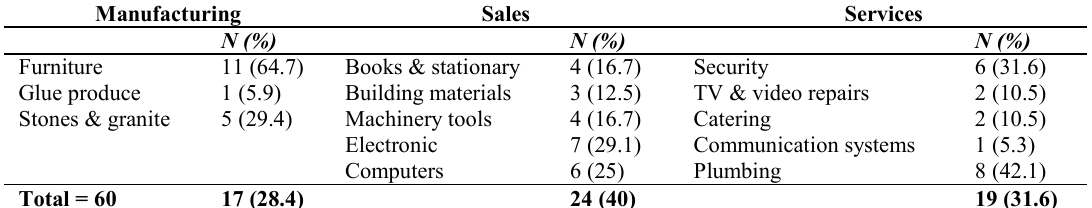
Table 1: Industry and type of small businesses interviewed (N=60) Manufacturing Sales